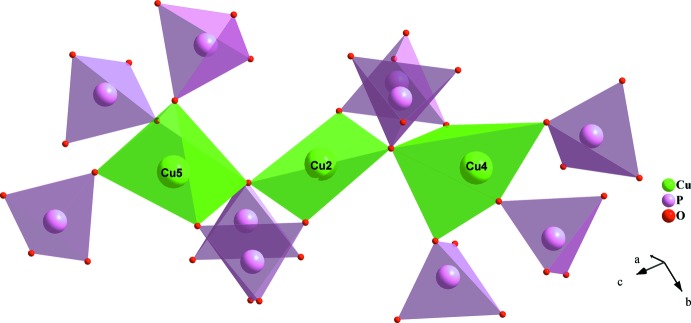
A [Cu3O12] trimer linked to PO4 through corners to build up a ribbon involving Cu4O5–Cu2O4–Cu5O5.